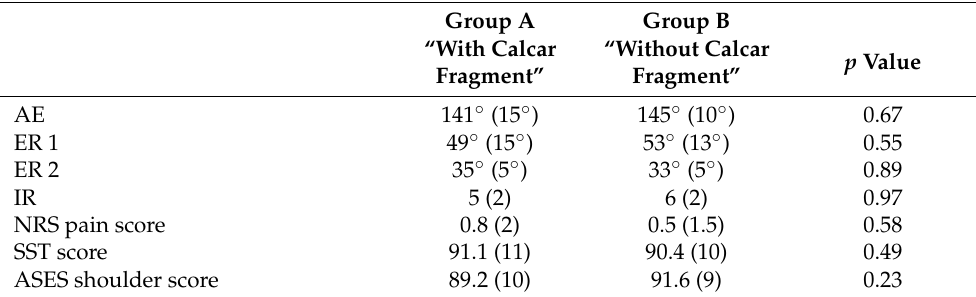
Table 2. Comparative analysis of postoperative clinical outcomes in proximal humeral fractures “with calcar fragment” vs. “without calcar